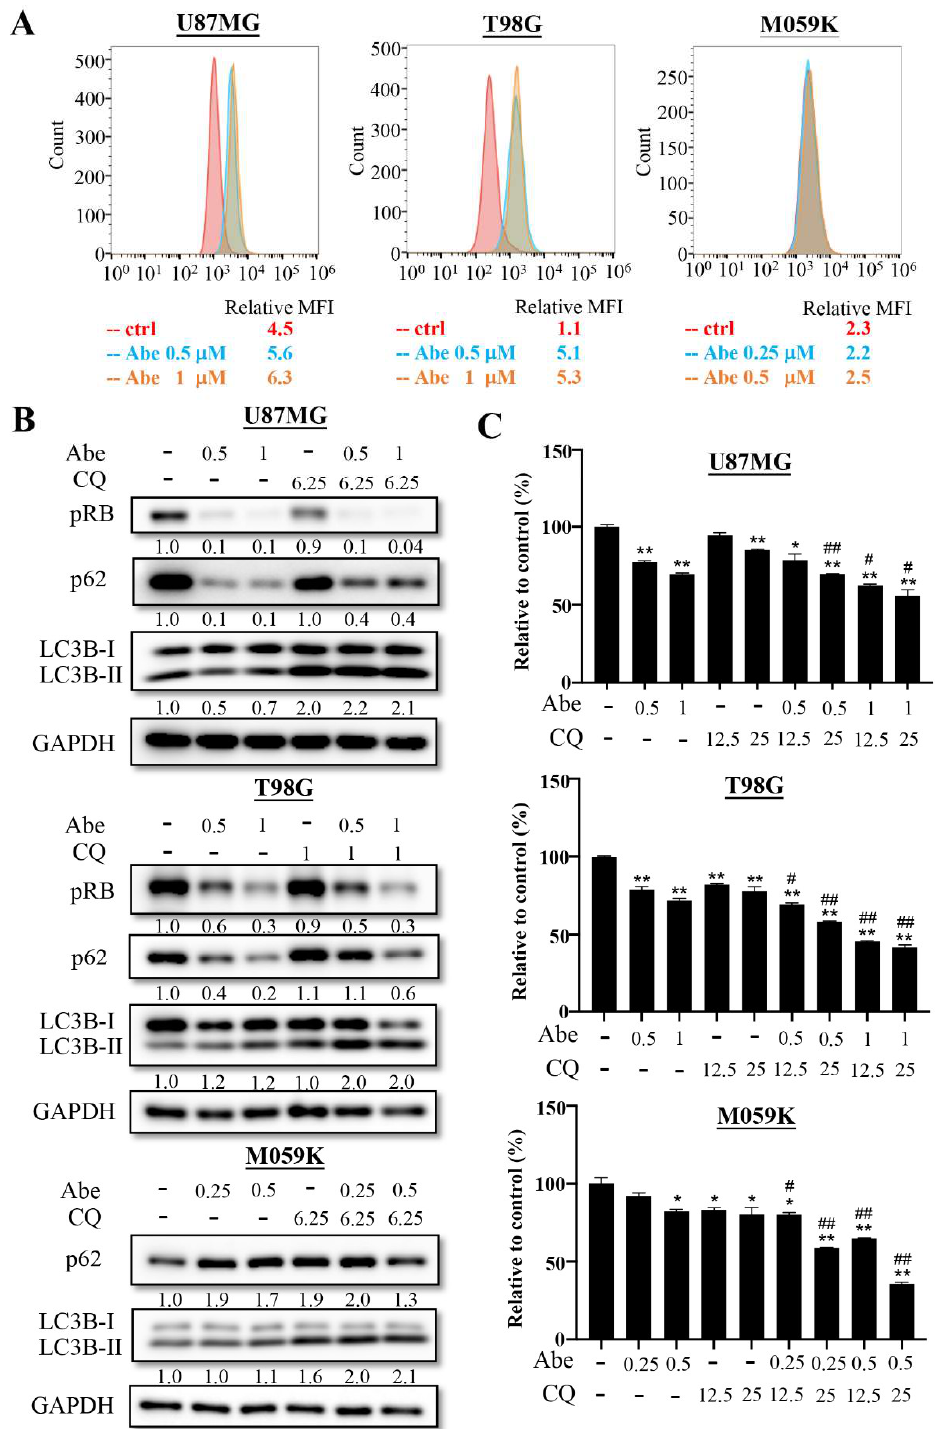
Figure 2. Abemaciclib treatment induces autophagy activation in GBM cells. ( A ) The three cancer cells were treated with control or the indicated concentrations of abemaciclib for 24 h, and autophagy was determined using the DAPGreen Detection Reagent and flow cytometry. The mean fluorescence intensity (MFI) value was relative to the unstained control. ( B ) LC3B-II intensity after abemaciclib treatment (Abe, μM) in the absence or presence of chloroquine (CQ, μM) was detected via Western blot analysis. ( C ) The three cancer cells were treated with indicated concentrations (μM) of abemaciclib in the absence or presence of chloroquine (μM) for 72 h and subjected to MTT assay. Data are presented as the mean ± SD of duplicate wells and are representative of three independent experiments. Abe: abemaciclib. CQ: chloroquine. (* p < 0.05, ** p < 0.01 compared to control group, # p < 0.05, ## p < 0.01 compared to indicated concentrations of abemaciclib) .